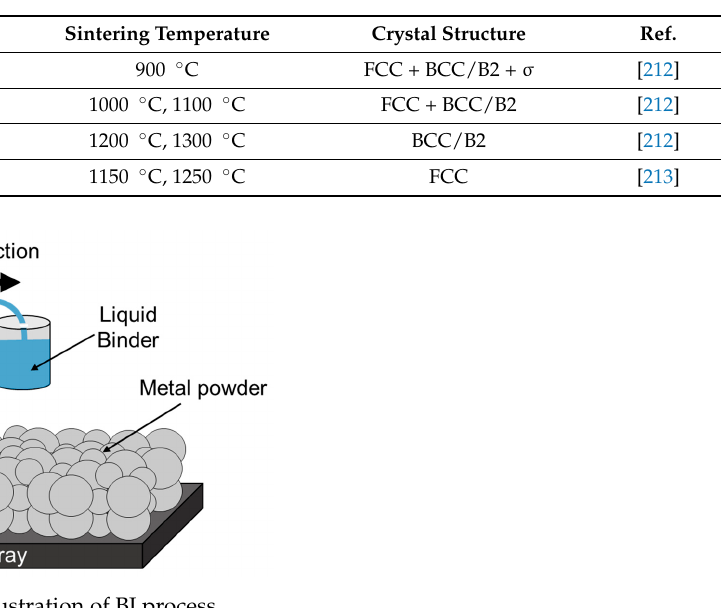
Table 7. HEAs fabricated by BJ process and pre-alloyed powders.